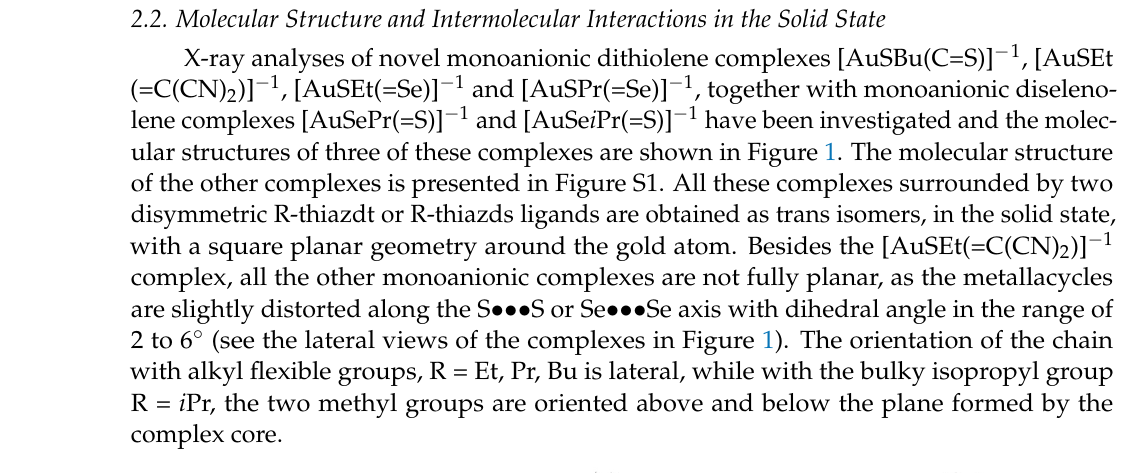
Table 1. Redox potentials of gold bis(dithiolene) and bis(diselenolene) complexes (E in V vs. SCE) in CH 2 Cl 2 , NBu 4 PF 6 , Pt, scan rate 100 mV.s –1 .